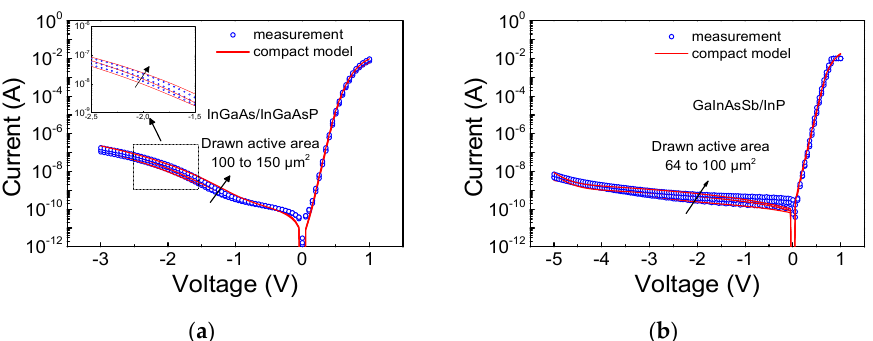
Figure 13. Measured (symbol) and simulated (lines) dark current-voltage characteristics of UTC-PDs with several active areas for ( a ) InGaAs/InGaAsP UTC-PD; ( b ) GaInAsSb/InP UTC-PD.